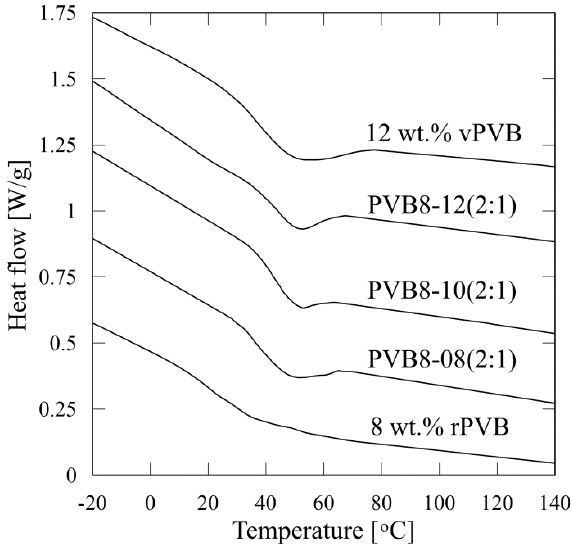
Figure 10. DSC thermograms of the tested PVB nanofibrous webs. Table 5. Evaluation of T g from DSC measurements of PVB